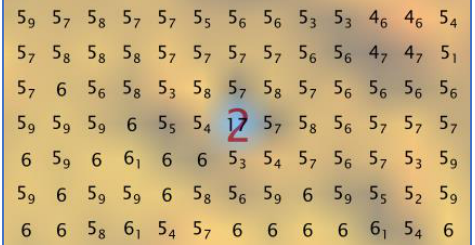
Figure 4. Example of a potential flier detected by the Gaussian Curvature algorithm (marked with an orange 2). The black values are depth values in meters from the evaluated grid; when shown, the sub-index represents decimeters. The algorithm bases the detection of potential fliers on the Gaussian curvature as a measure of the concavity at each node.